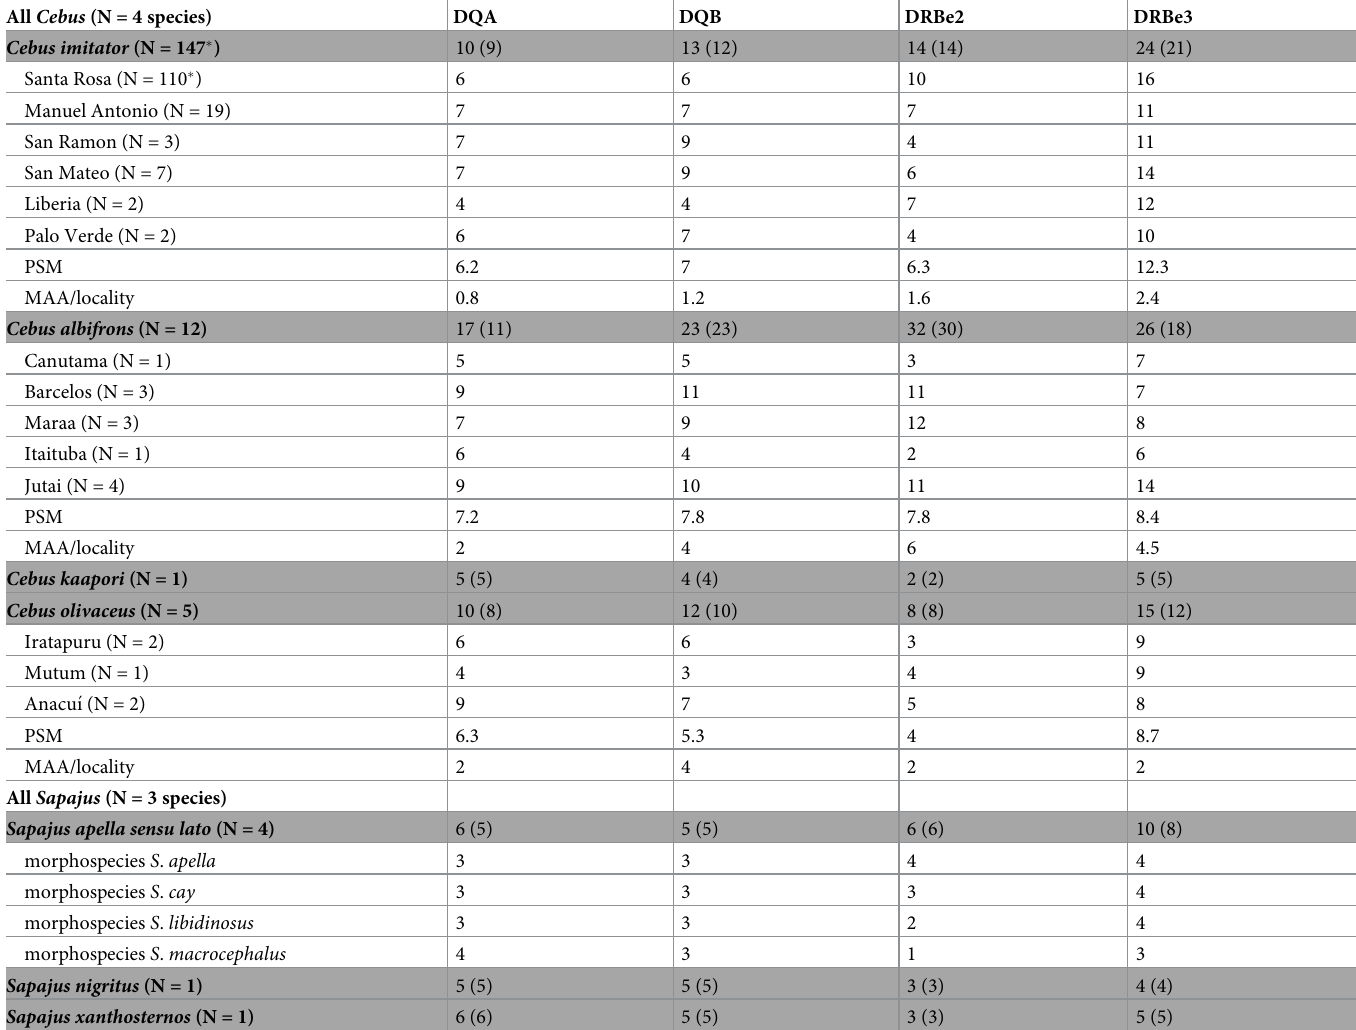
Table 2. Number of unique alleles (and amino acid) sequences